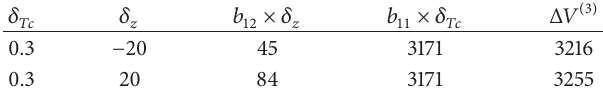
Table 2: The influence of rudder deflection to velocity system.